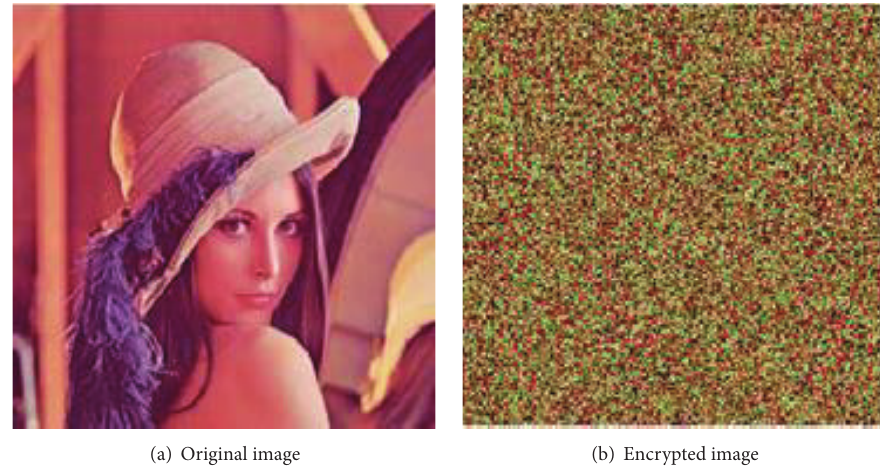
Figure 9: Original image and encrypted